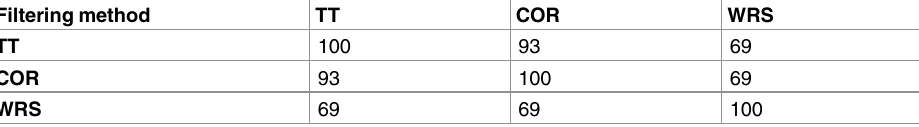
Table 2. Similarity percentages for sets of 200 discriminative genes selectedby various filtering